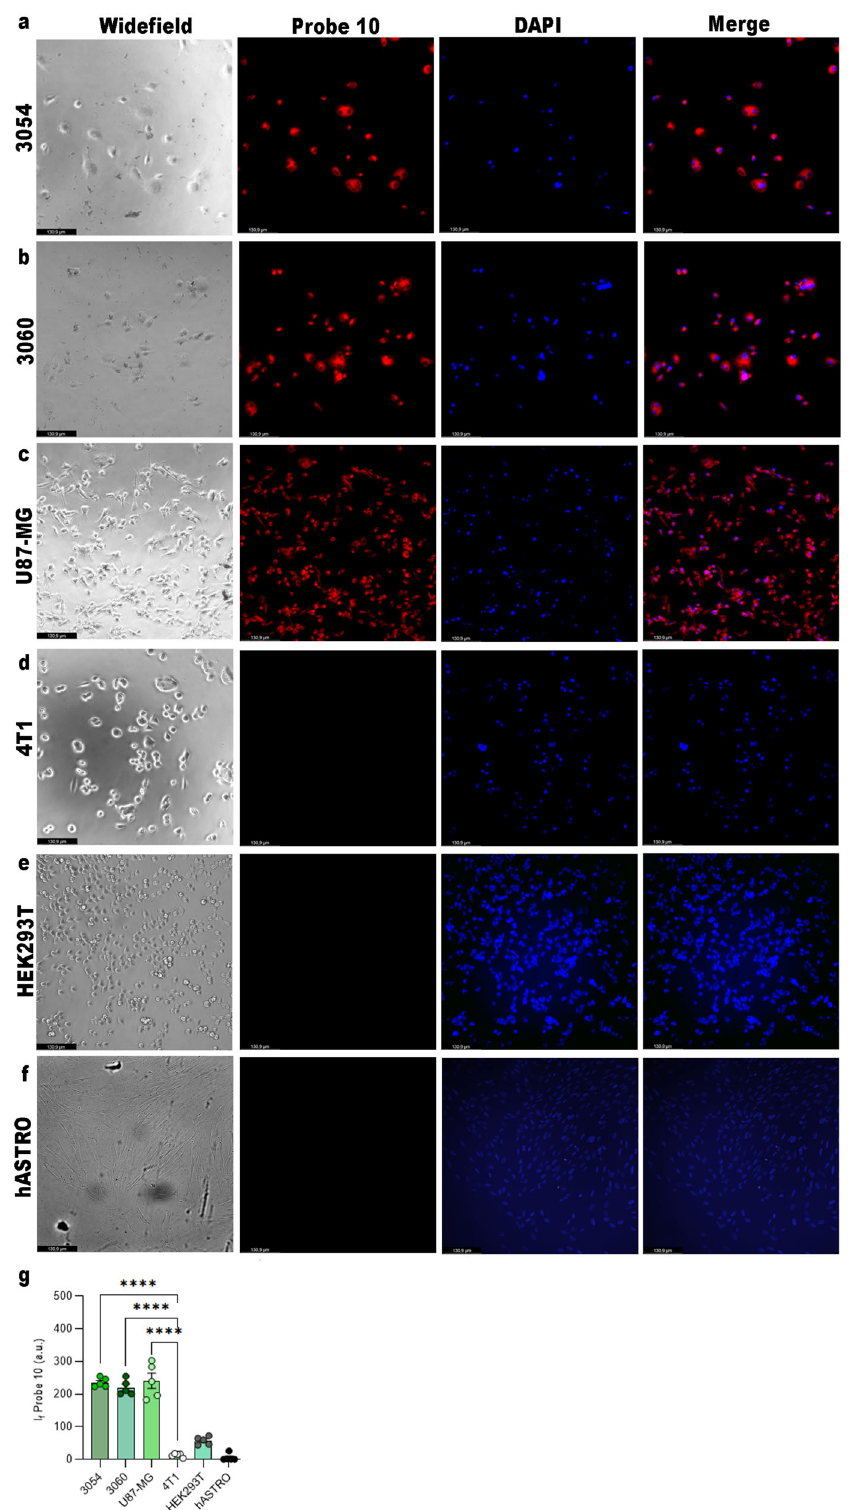
Fig. 5 Probe 10 is selective on glioblastoma ALDH1A3 positive cells. Fluorescence microscope images for Probe 10 detection in a patient-derived glioma cell 3054, b 3060, c U87MG, d 4T1, e HEK293T and f normal hASTRO at 10 µ M, after 2 h of incubation. g Relative fl uorescence intensity of the images acquired. **** p value